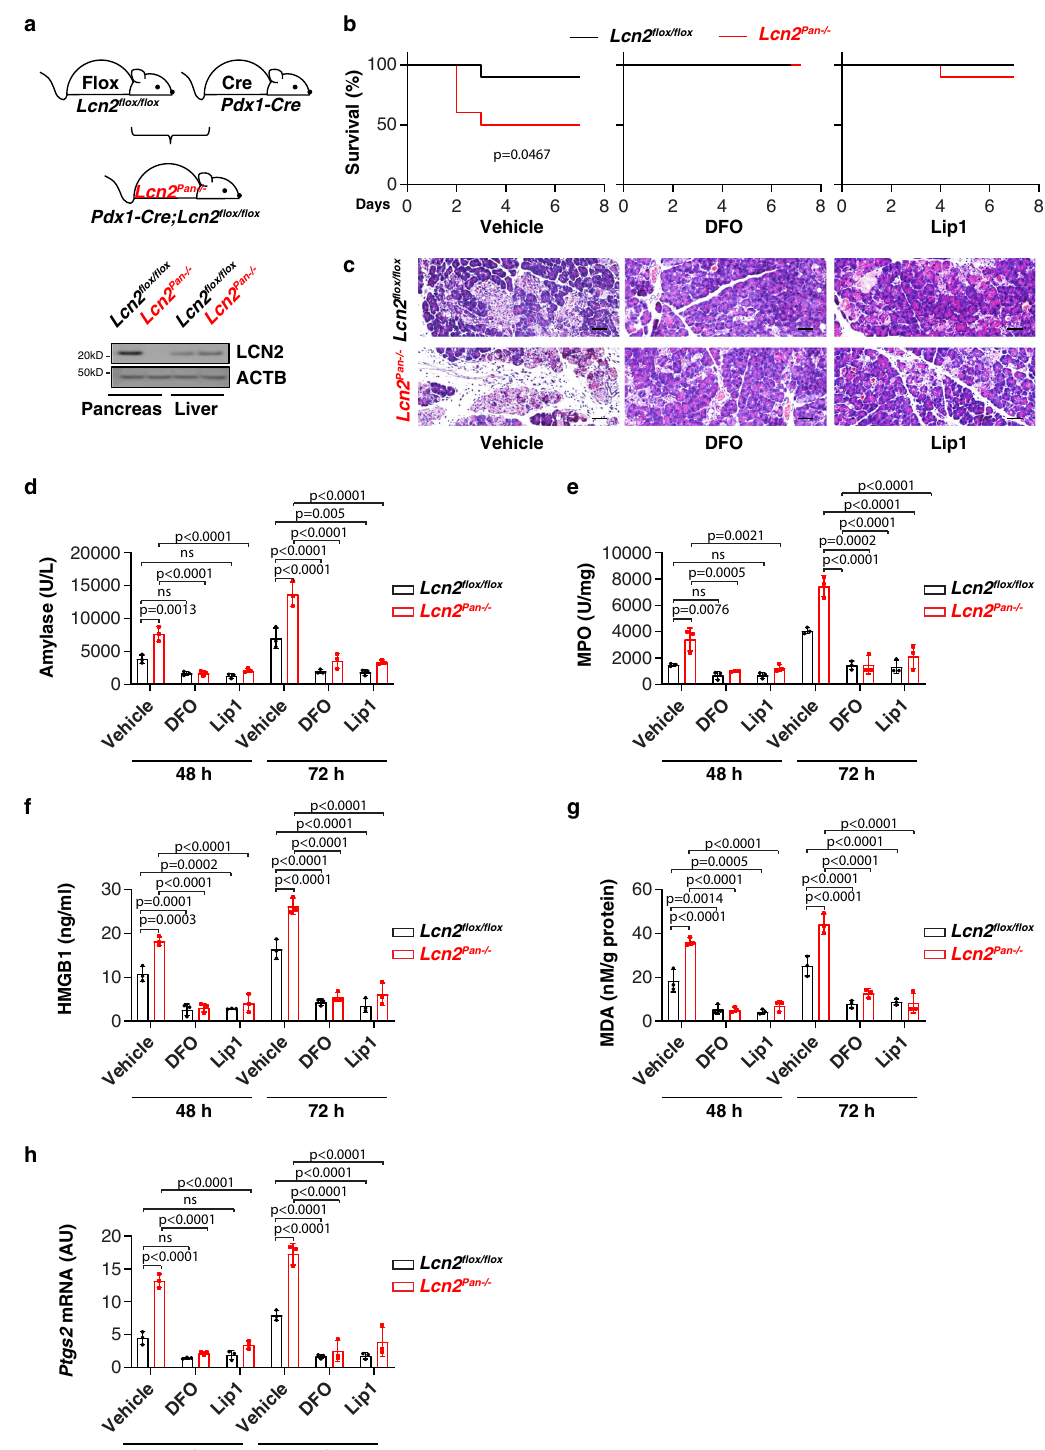
Fig. 6 LCN2 prevents pancreatitis through the inhibition of ferroptosis. a Western blot analysis of LCN2 expression in the pancreas and liver in Lcn2 fl ox/ fl ox and pancreas-speci fi c conditional Lcn2 knockout mice ( Lcn2 Pan − / − ). b Animal survival in Lcn2 fl ox/ fl ox and Lcn2 Pan − / − mice in response to L -arginine-induced acute severe pancreatitis in the absence or presence of liproxstatin-1 or DFO ( n = 10 mice/group; one-sided Log-rank [Mantel – Cox] test). c – h In parallel, hematoxylin and eosin-stained pancreatic sections ( c ), serum amylase ( d ), pancreatic MPO ( e ), serum HMGB1 ( f ), pancreatic MDA ( g ), and mRNA expression of Ptgs2 in the pancreas ( h ) were assayed at the indicated time points ( n = 3 mice/group; two-way ANOVA with Tukey ’ s multiple comparisons test on all pairwise combinations). Bar = 50 μ m. ns: not signi fi cant. Data in d – h are presented as mean ± SD. The results in b – h